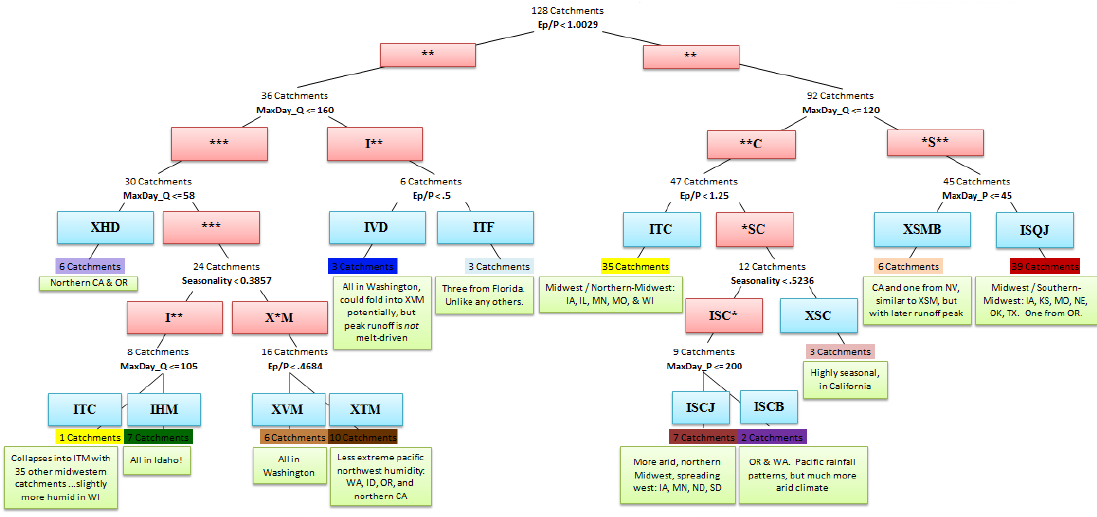
Fig. 11. Higher seasonality, non-arid: expanded (terminal nodes in